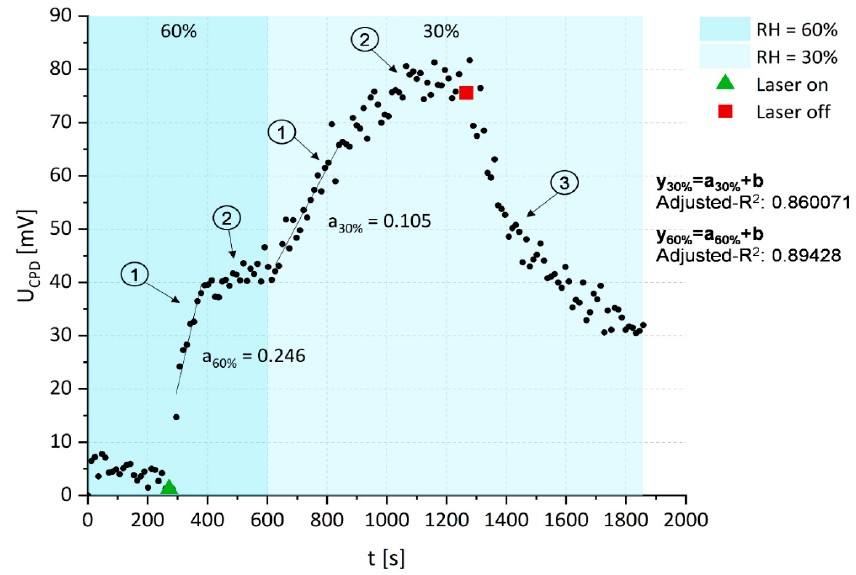
Figure 6. The changes of U CPD on stainless steel with a PS-doped silica coating depending on the laser irradiation at 655 nm wavelength and the relative humidity in the measurement chamber (1—high rate of the free radicals generation, 2—saturation of free radical generation, and 3—decay of the free radicals generation).